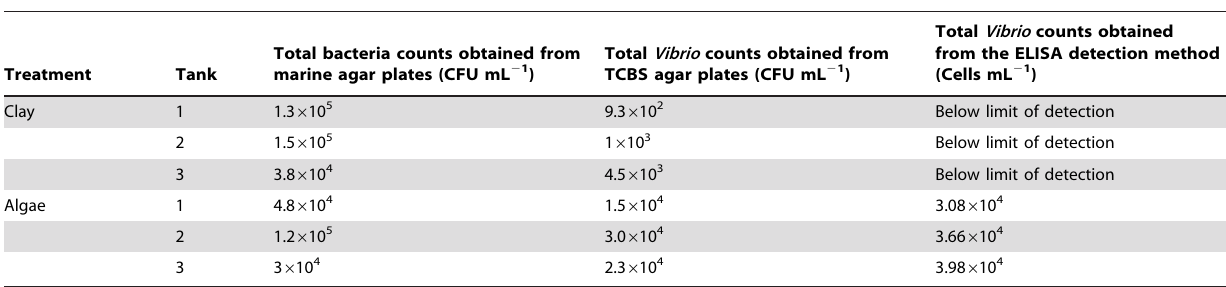
Table 3. Comparison of the Vibrio counts obtained using both the TCBS plate culturing and ELISA detection method.